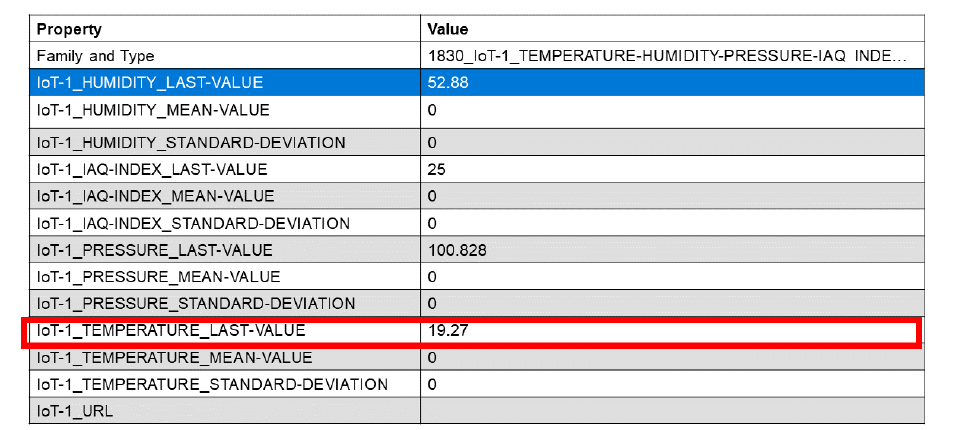
Figure 15. Debugging phase of BIM updater: data retrieved from System BUS, saved into IFC file and then visualized into the BIM model visualizer.